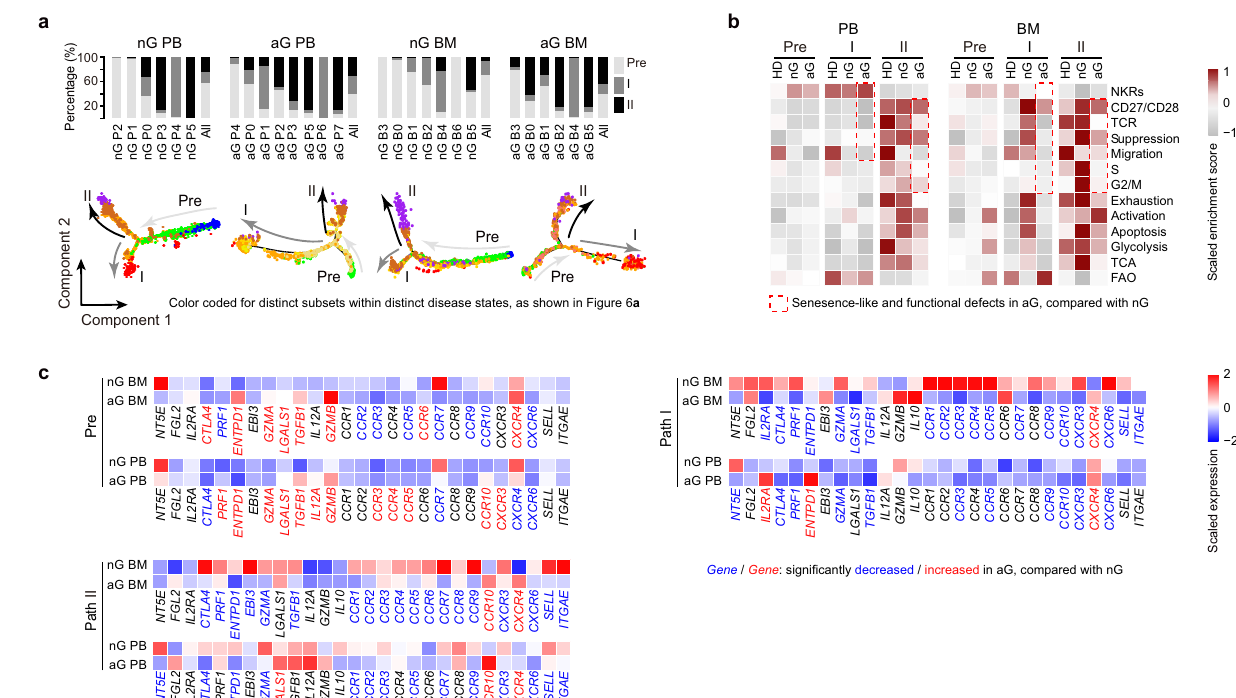
Fig. 7 T reg Paths in allo-HSCT patients with or without aGVHD. a Trajectory analysis for T reg cell clusters in allo-HSCT patients, colored by subsets (nG PB: n = 3, nG BM: n = 3, aG PB: n = 4, nG BM: n = 3). The insert picture shows the proportions of different T reg cell paths in each subset. b Heatmaps showing the GSVA enrichment score of selected pathways for each T reg cell path. c Heatmaps showing the expression of migration and suppression- associated genes in T reg Paths. The blue font indicated that the genes were signi fi cantly down-regulated in aGVHD patients, compared with non-aGVHD patients ( p < 0.05). The red font indicated that the genes were signi fi cantly up-regulated in aGVHD patients, compared with non-aGVHD patients ( p < 0.05). In c , gene normalized expressions were used and p values were determined by Wilcoxon rank-sum test. Source data are provided as a Source Data fi